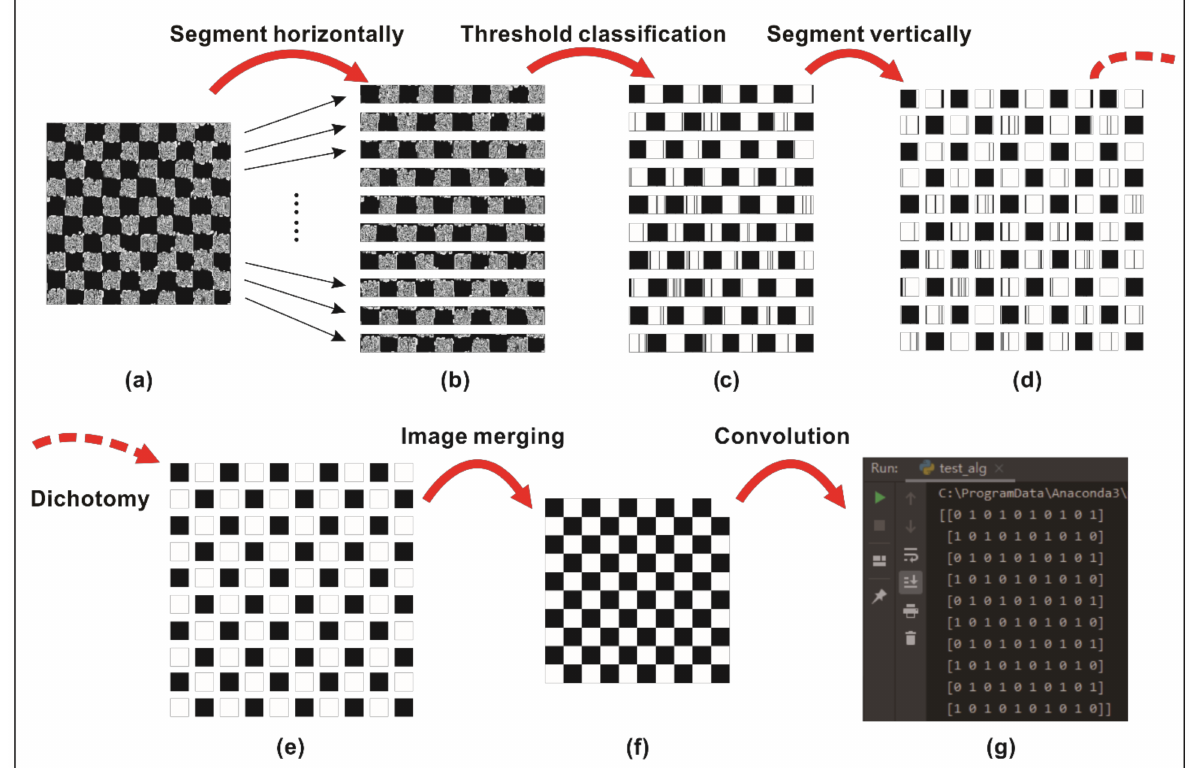
Figure 10. The image compression process: ( a ) preprocessed image; ( b ) grayscale sub-image arrays of ten weft yarns; ( c ) binary sub-image arrays of ten weft yarns; ( d ) preliminary texture pattern; ( e ) preliminary texture pattern processed by dichotomy; ( f ) final texture pattern; and ( g ) the output matrix, F